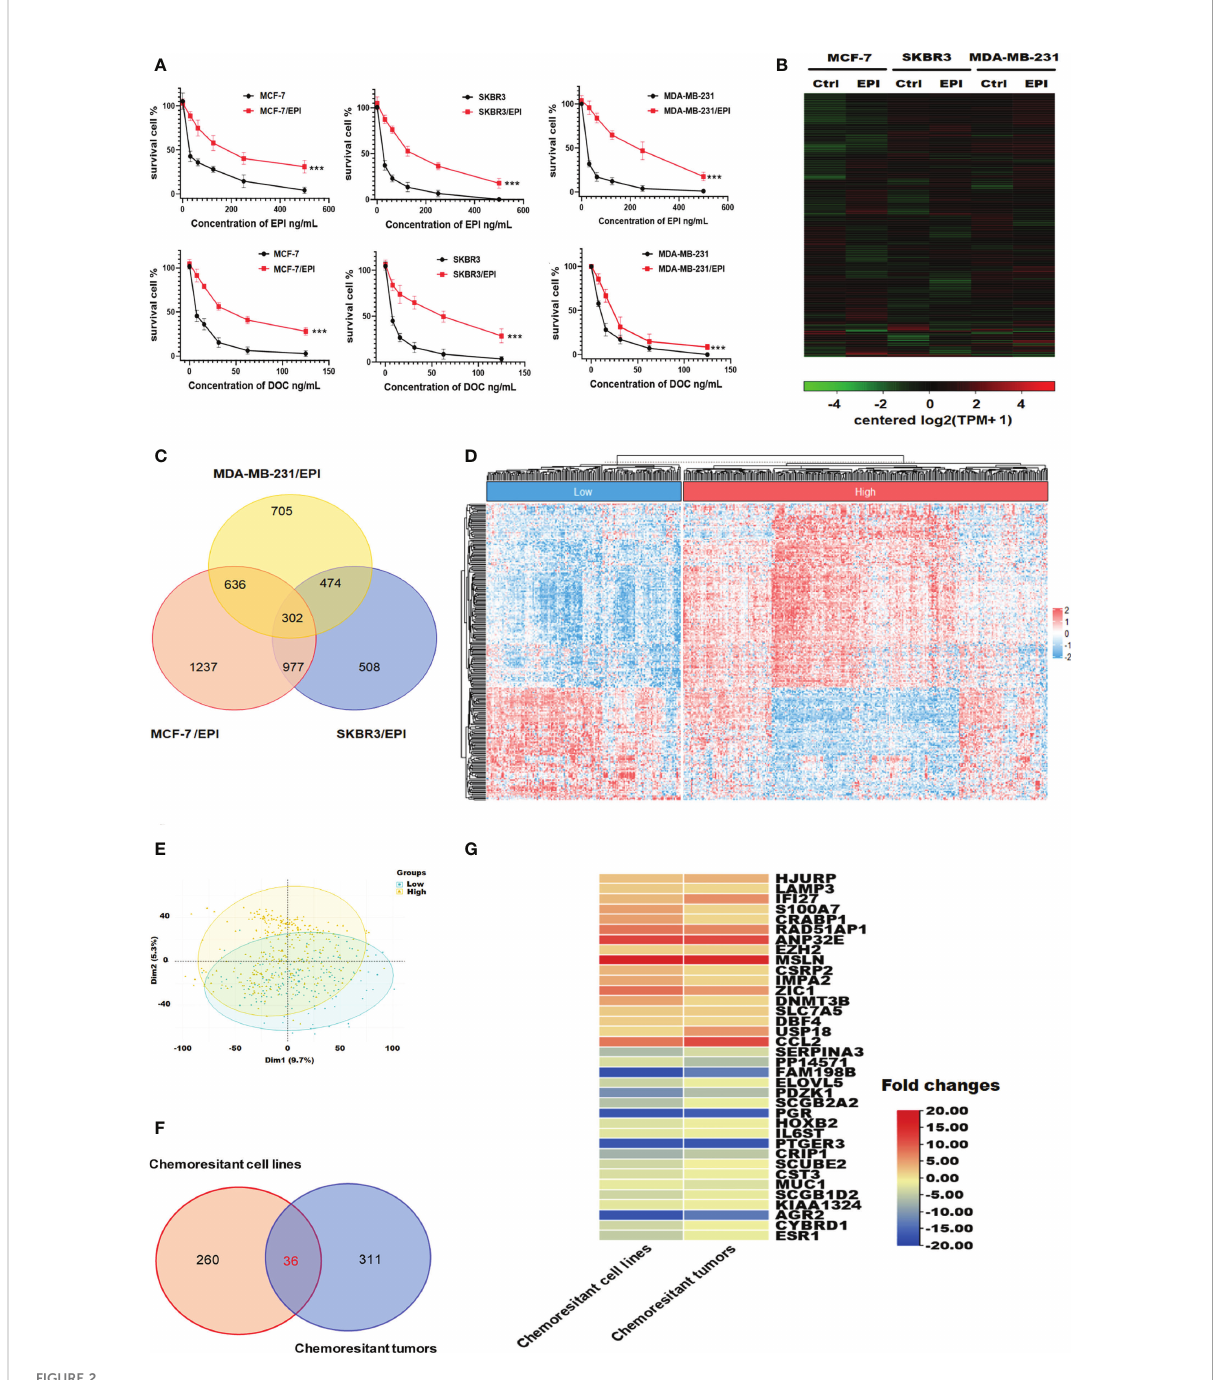
FIGURE 2 Visualization of genes differentially expressed in chemo-resistant breast cancer cells. (A) Drug toxicity of EPI and DOC to resistant cells. (B) Heatmaps of DEGs in EPI-resistant cells. (C) Overlapping DEGs that were up/down-regulated over 2-fold among EPI-resistant cells lines. (D) Heat map of DEGs that were up/down-regulated over 1-fold among chemotherapy-resistant (n=157) and -sensitive patients with breast cancer (n=335). (E) Principal component comparison of gene expression in chemotherapy-resistant and -sensitive patients with breast cancer. (F) Overlapping DEGs among EPI-resistant cells lines and tumors of chemotherapy-resistant patients. (G) Heatmaps of commonly up/down- regulated DEGs in both the NAC chemo-resistant cells and tumors compared in contrast to the WT cells and sensitive tumors. Data are presented as mean ± SD (P <